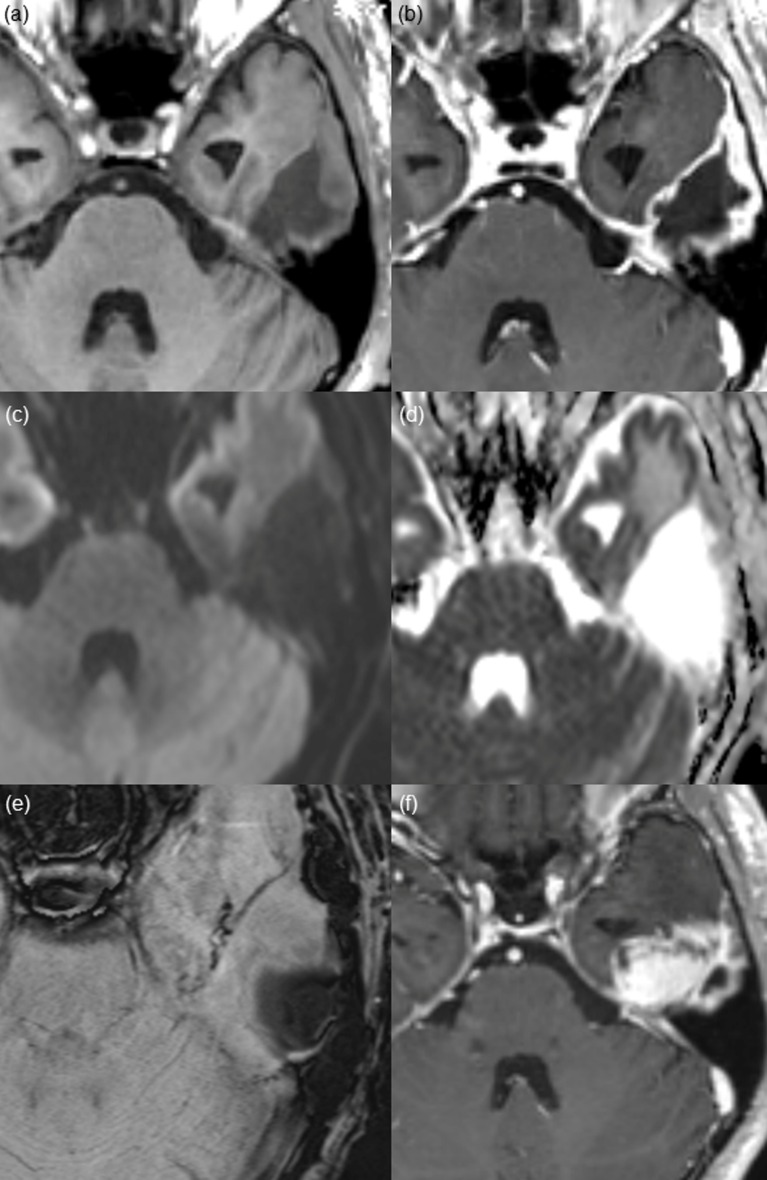
Thick wall enhancement pattern found on post-CCRT MR imaging from a 50-year-old male patient after gross total resection of glioblastoma.(a and b) Pre- and post-contrast enhanced T1 WI shows thick and irregular enhancement along the surgical cavity. (c) DWI and (d) ADC map show no diffusion restriction. Considering the dark signal intensity on (e) SWI, it reflects hemorrhage. (f) On 14-month follow-up contrast-enhanced T1 WI, the surgical cavity has shrunk, and a measurable mass has developed at the inferior aspect of the surgical cavity, which is pathologically confirmed as a recurred glioblastoma.